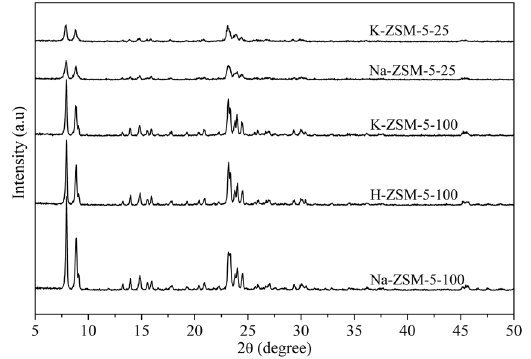
Figure 1. XRD patterns of the samples.